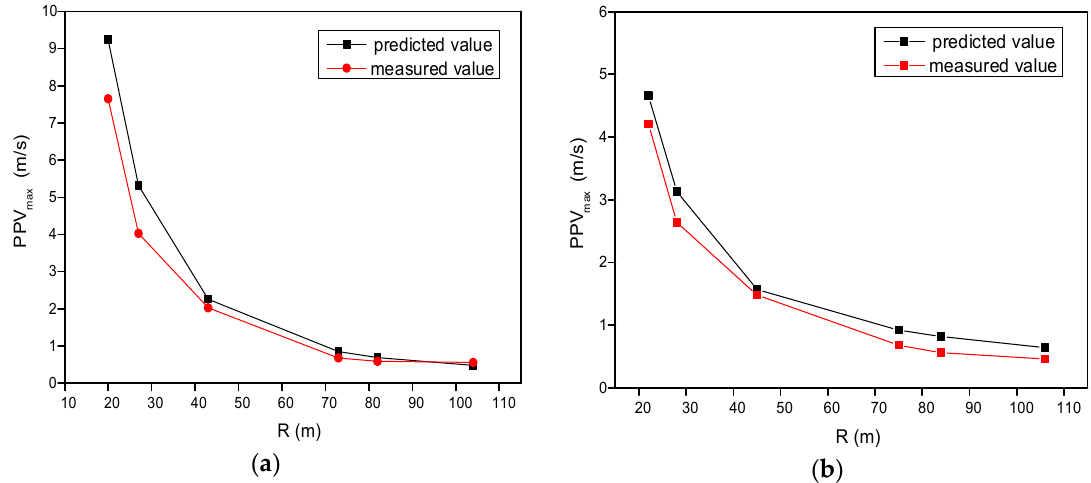
Figure 13. Maximum blast vibration velocity at di ff erent distances. ( a ) Region V and ( b ) region